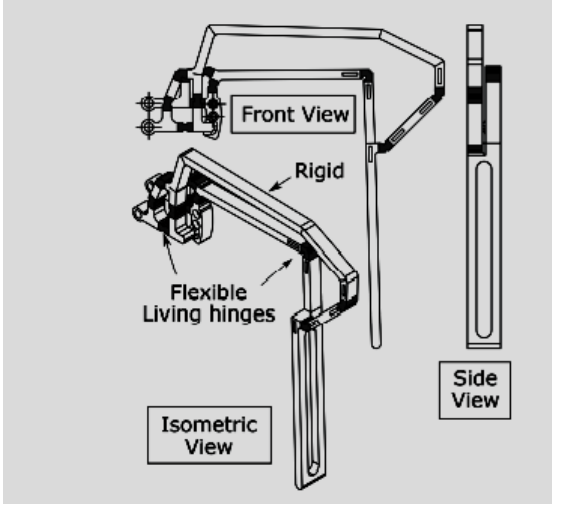
Figure 22. Computer-aided design of the arm wing structure mimicking a Bat’s wing